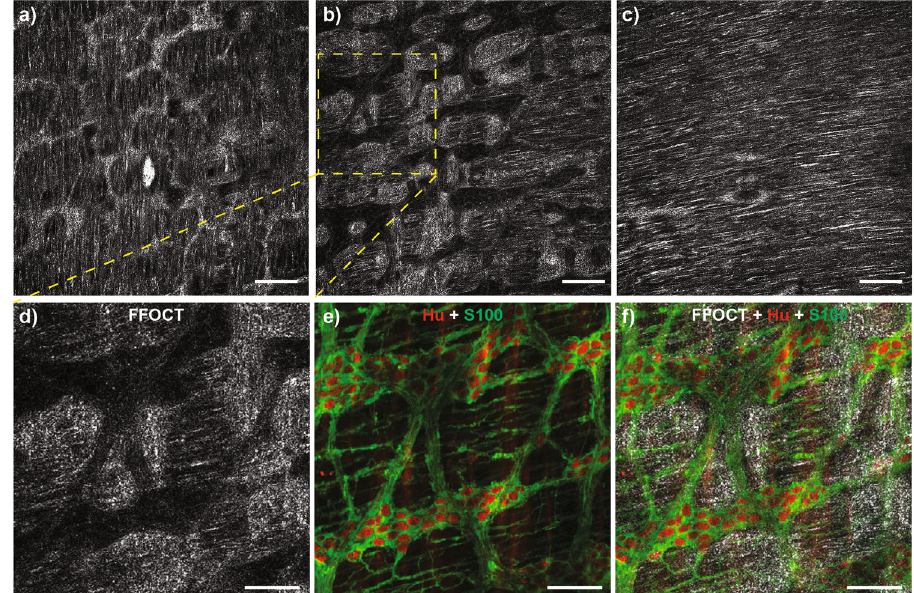
Fig. 1 FFOCT identi fi cation of the myenteric plexus in the mice colon. a – c The mice colon was analyzed by FFOCT at the level of a longitudinal muscle, b myenteric plexus, and c circular muscle. Selected area of the myenteric plexus was visualized by d FFOCT and by e apotome after the immunolabelling of neurons (Hu in red) and enteric glial cells (S100b in green). The merged image ( f ) con fi rms that the dark areas observed by FFOCT correspond to ganglia and interganglionic fi ber tracts. Scale bar: a – c 200 µ m; d – f 100 µ Light-CT scanner are pseudo-colored RGB images where each color channel is built on the Fourier-domain analysis of the micromotions integrated on three different frequency ranges. The low [0 – 0.6 Hz], medium [0.6 – 5.4 Hz] and high [5.4 – 25 Hz] frequencies were color-coded into blue, green, and red, respectively (Fig. 2g – i). To improve the contrast, and visualize and quantify chrome images corresponding to their three color channels. Using